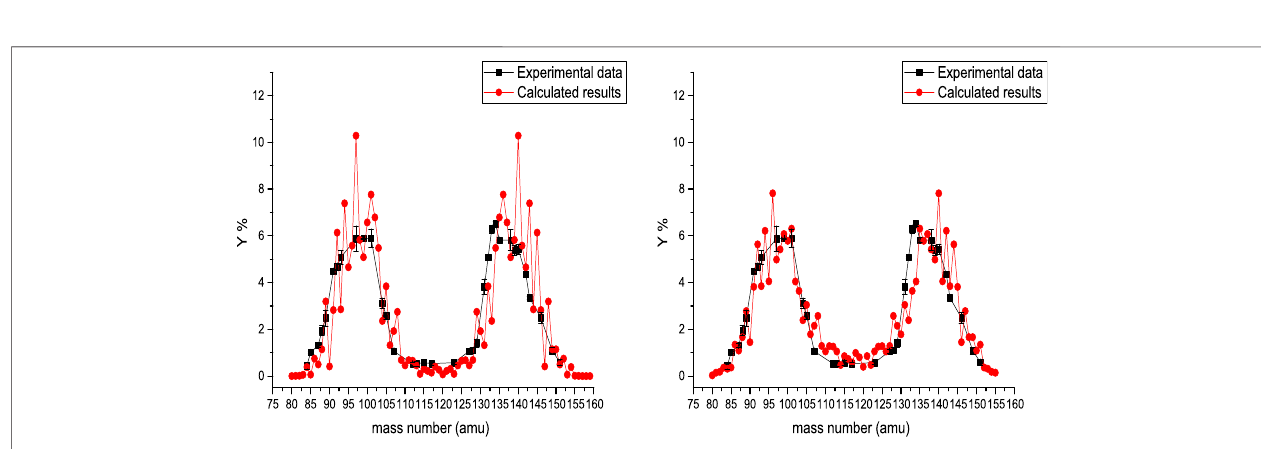
FIGURE 3 | Calculated mass yield for photo fi ssion of 238 U at 67.8 MeV bremsstrahlung endpoint energy, accompanied by experimental data [37]. In the left and right sides are presented the calculated results obtained for T coll (cid:1) 1 MeV and T coll (cid:1) 2 MeV, respectively.